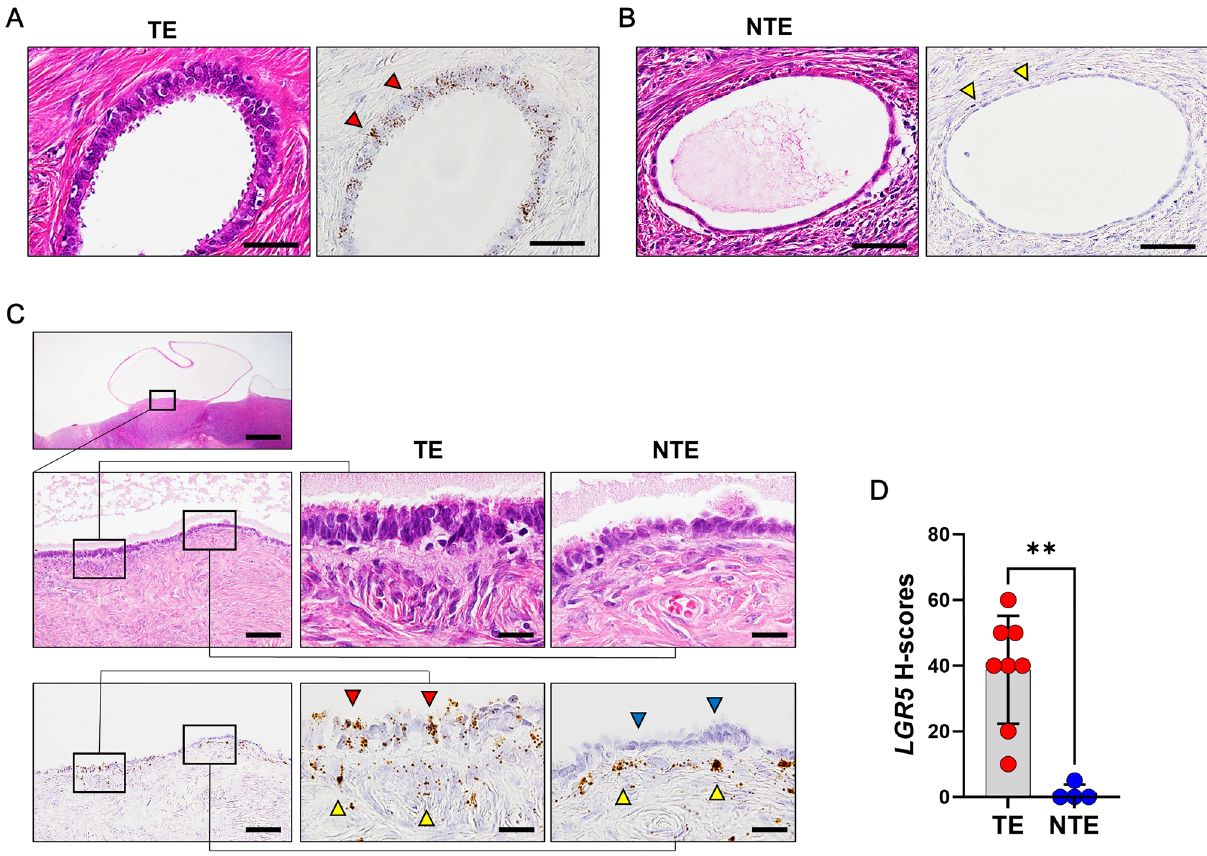
Figure 2. LGR5 expression in the inclusion cysts . ( A ) The tubal type epithelium (TE) of an inclusion cyst showing a significant level of LGR5 expression (indicated by red arrowheads). Scale bar, 50 µm. ( B ) Inclusion cysts that have nontubal type epithelium (NTE) express no or negligible levels of LGR5 (indicated by yellow arrowheads). Scale bar, 50 µm. ( C ) An inclusion cyst that contains both TE and NTE. LGR5 expression is observed in the TE (indicated by red arrow heads) along with strong LGR5 expression in subepithelial stromal cells (indicated by yellow arrowheads), whereas NTE does not express LGR5 (indicated by blue arrowheads). Scale bar, 0.5 mm (left upper panel), 0.2 mm (left middle and lower panels) and 20 µm (middle and right panels). ( D ) A bar graph showing histo-scores (H-scores) of LGR5 in the inclusion cysts with TE (n = 8) or NTE (n = 4). ** P < 0.01 by unpaired t